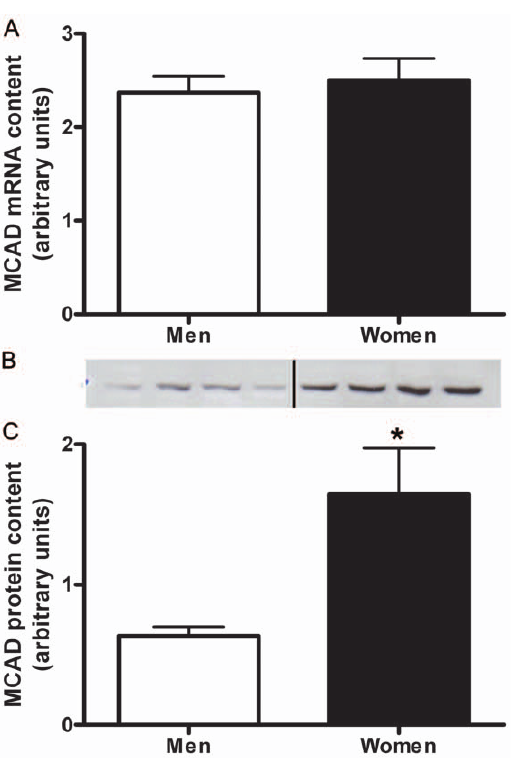
Figure 2. MCAD protein content is higher in women than men. Differences in MCAD mRNA content between men and women shown by Real time RT-PCR, adjusted to b 2-M mRNA (A). Protein content of MCAD in skeletal muscle of men and women, adjusted to CS (B,C). Representative western blot (B) Lanes 1–4 are men, lanes 5–8 women. N=12 men and 11 women. *P # 0.05.